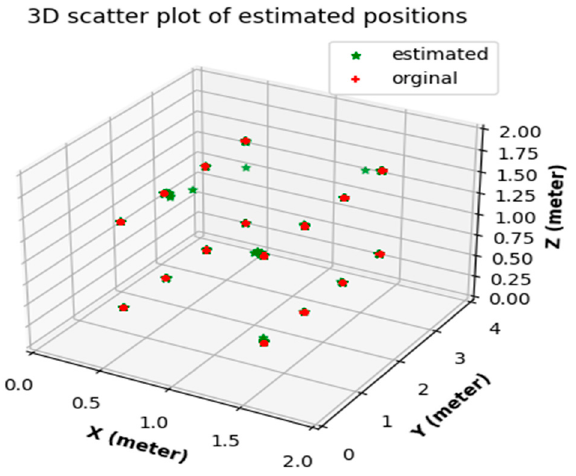
Figure 12. Results of 3D position estimation for all 16 classes.